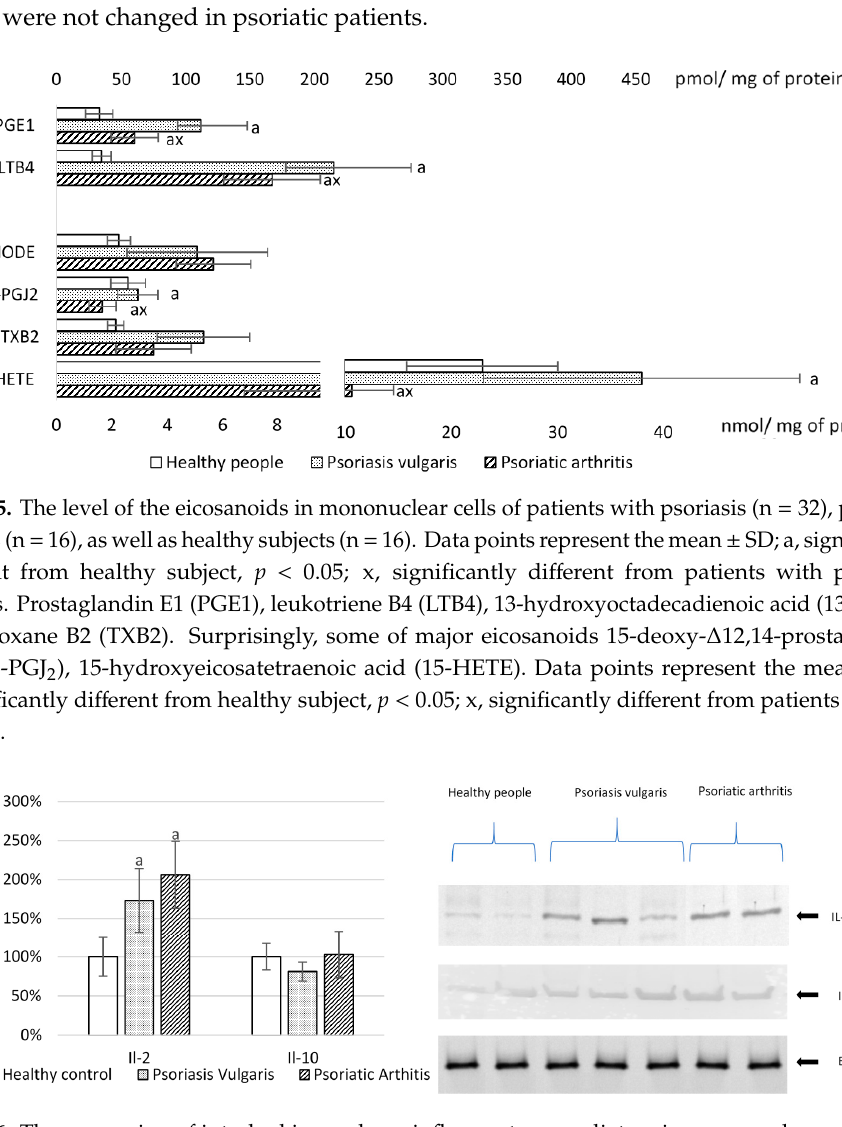
Figure 4. The expression of receptors involved in phospholipid metabolism in mononuclear cells of patients with psoriasis vulgaris (n = 16) and psoriatic arthritis (n = 8) and healthy peoples (n = 8). CB1, CB2, cannabinoid receptors; GRP55, G protein-coupled receptor 55; TRPV, the transient receptor potential cation channel subfamily V member 1; PPAR, peroxisome proliferator-activated receptor. Data points represent the mean ± SD; a, significantly different from healthy subjects, p < 0.05; x, significantly different from patients with psoriasis vulgaris, p < 0.05.